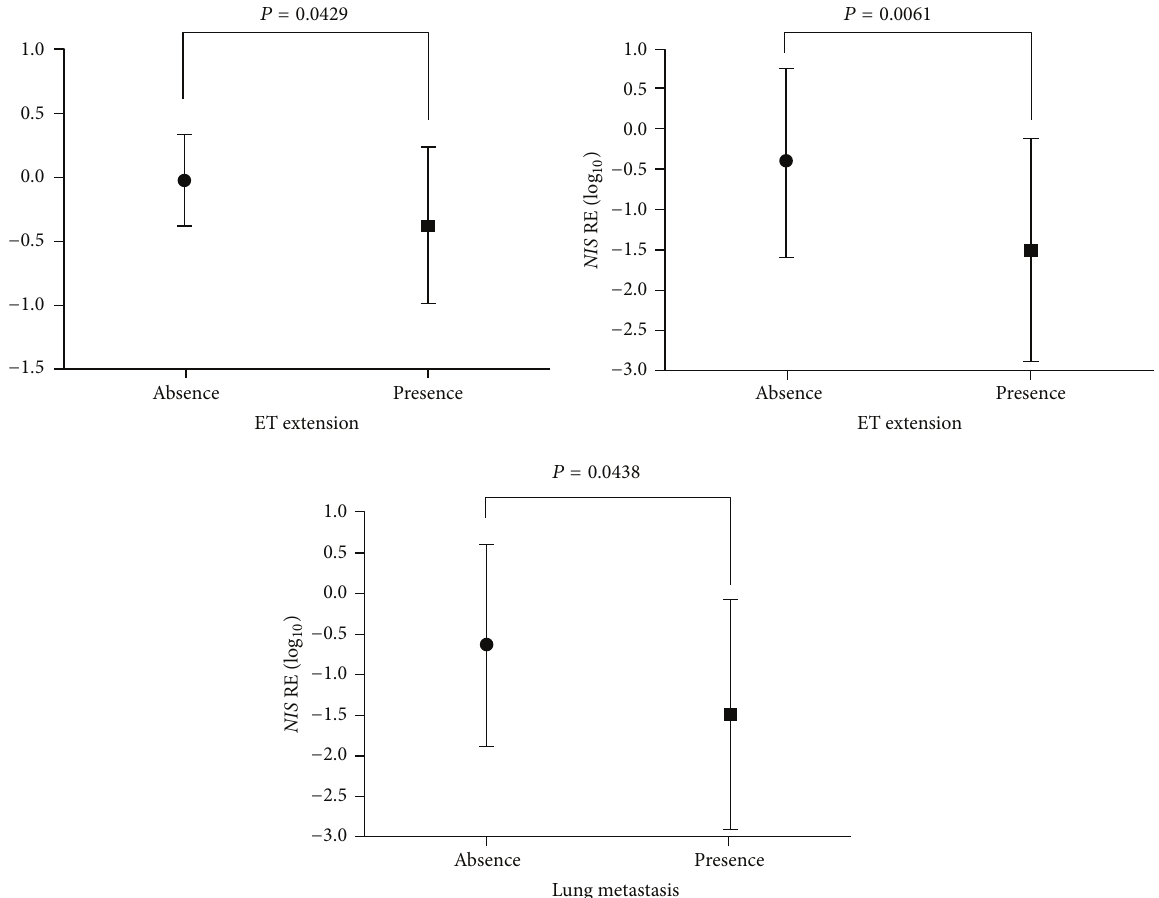
Figure 3: Relative expression (RE) of TSHR and NIS in pediatric thyroid carcinomas classified according to the presence ( 𝑛 = 22 ) or absence ( 𝑛 = 16 ) of extrathyroidal (ET) extension; and RE expression of NIS in patients classified according to the presence ( 𝑛 = 10 ) or absence ( 𝑛 = 28 ) of distant metastasis. The graphics shows the mean value ( ± SD) of log-transformed data. 𝑃 < 0.05 were considered statistically